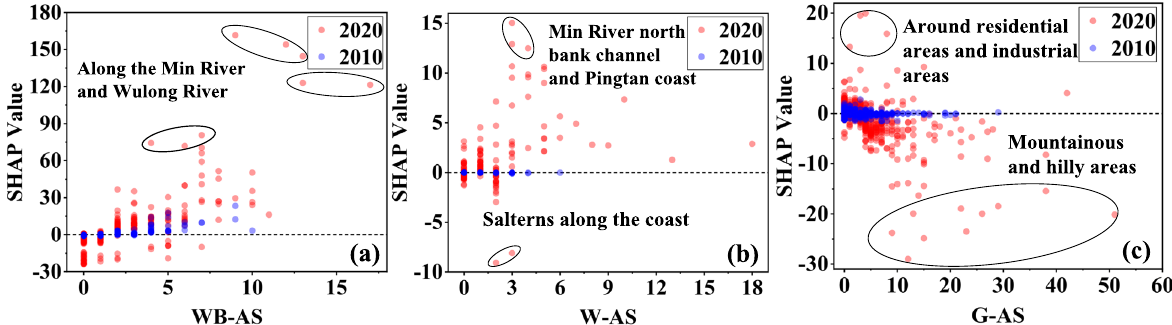
Fig. 6 SHAP dependence plots of LCSC of ( a ) WB-AS ( b ) W-AS ( c ) G-AS in 2010 and